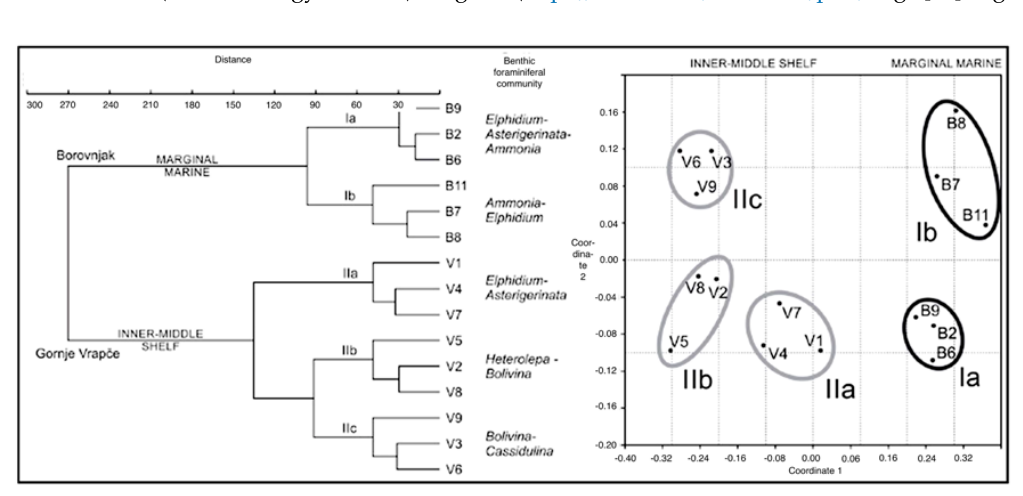
Figure 6. Example of statistical comparison of fauna from di ff erent localities using cluster analysis and non-metric multidimensional scaling analyses (after